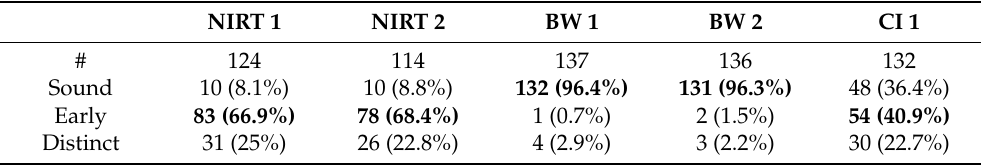
Table 3. Frequency (%) distribution of scores for each diagnostic method for both assessments (Clini- cal images (CI), near-infrared transillumination (NIRT), and bitewing radiographs (BW)) excluding missing, filled, and non-interpretable surfaces. The most relevant results are in